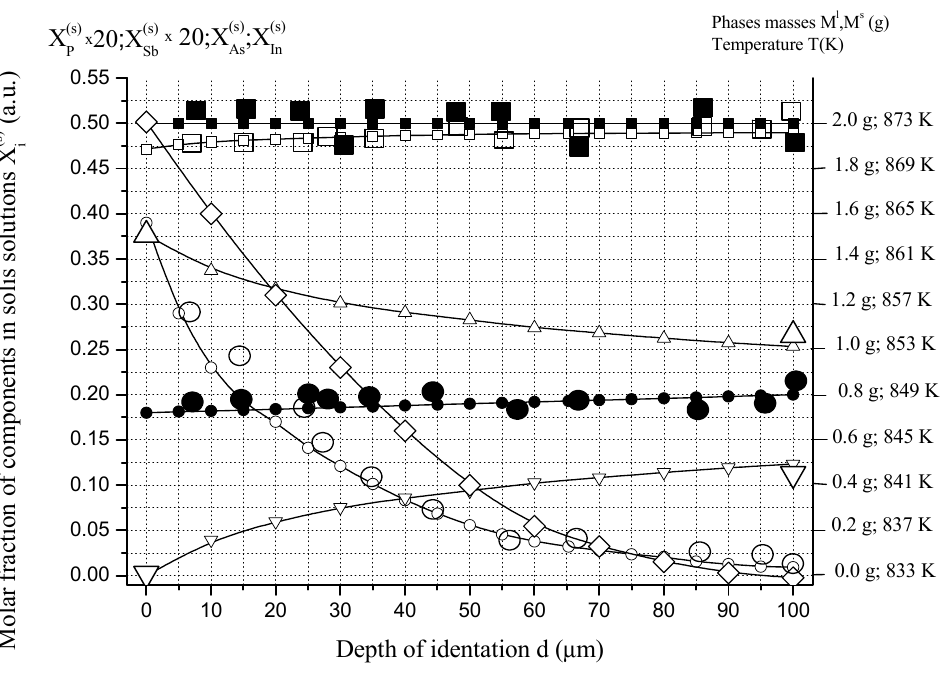
Figure 2. Dependence between the ternary solid solution composition ( x ) and indentation depth (d) in the In-P-As-Sb system : P, ○ ; Sb, ● ; As, □ ; In, ■ ; melt mass, △ ; solid solution mass, ▽ ; crystallization temperature, ◇ : little points, calculation; large points, experimental data [18]. Conditions of experiment: initial crystallization temperature T s = 923 K, final crystallization temperature T f = 883 K ; initial melt mass m ( l )0 = 1.4009 g; substrate ( InAs ) area S = 0.81 cm 2 .